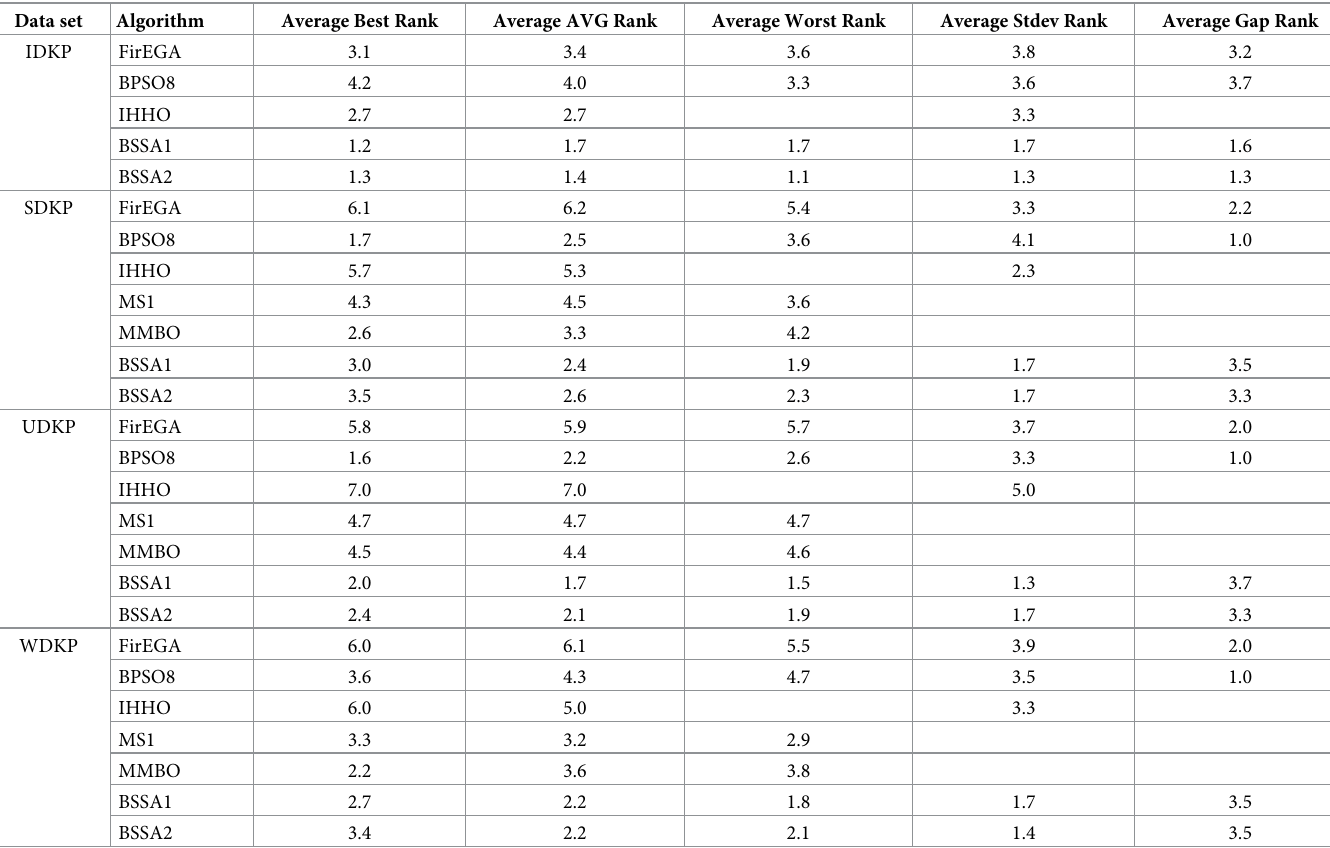
Table 9. The average ranks of tested algorithms by data set